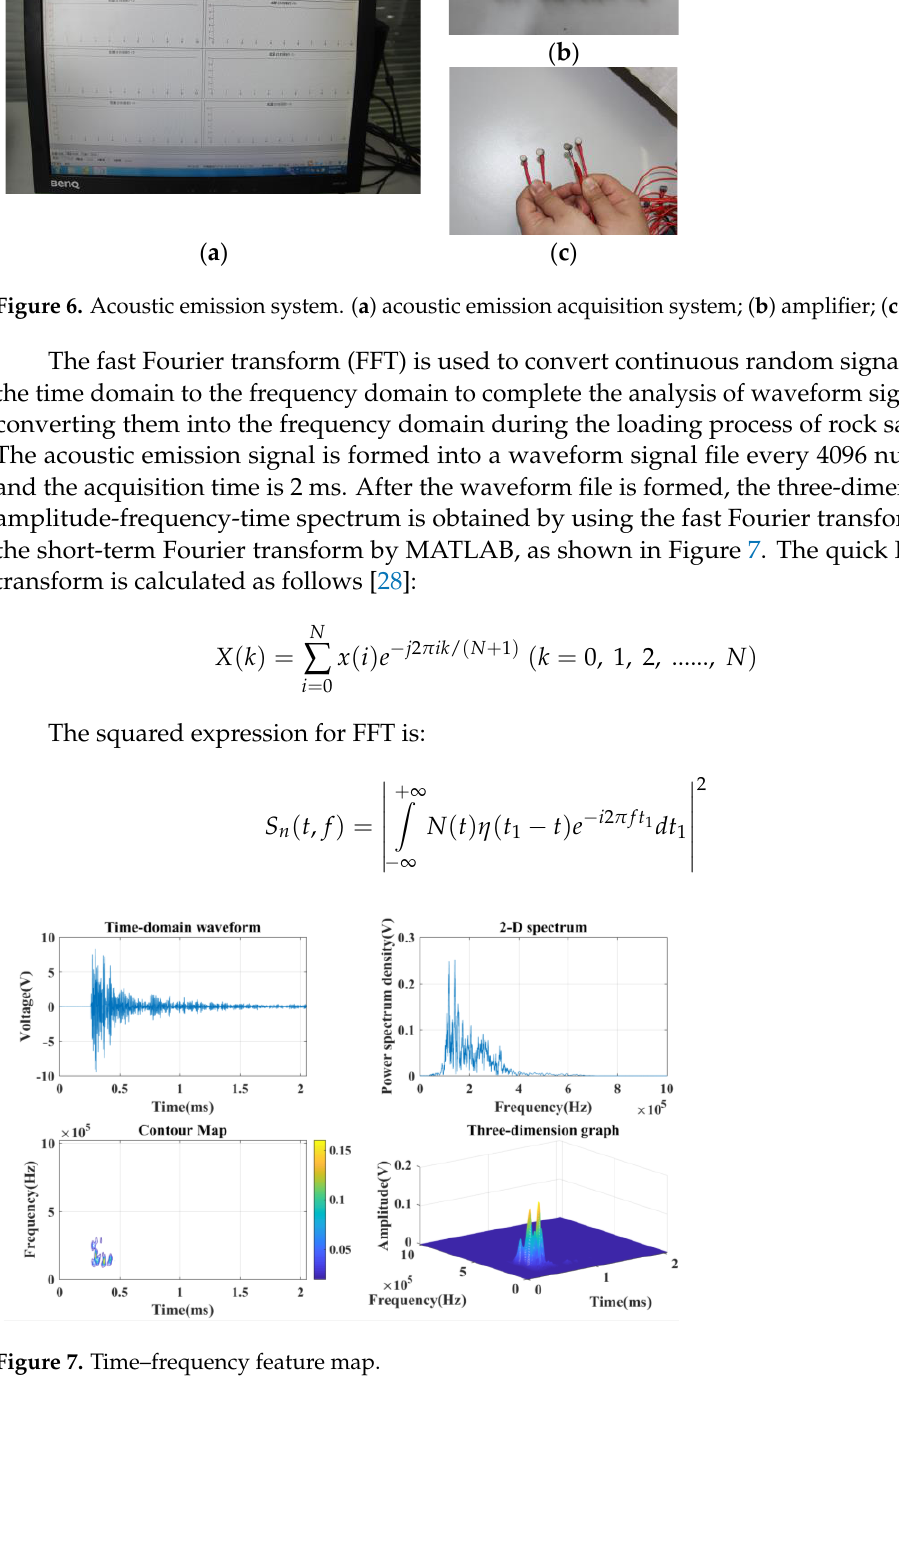
Table 2. Level of stress.